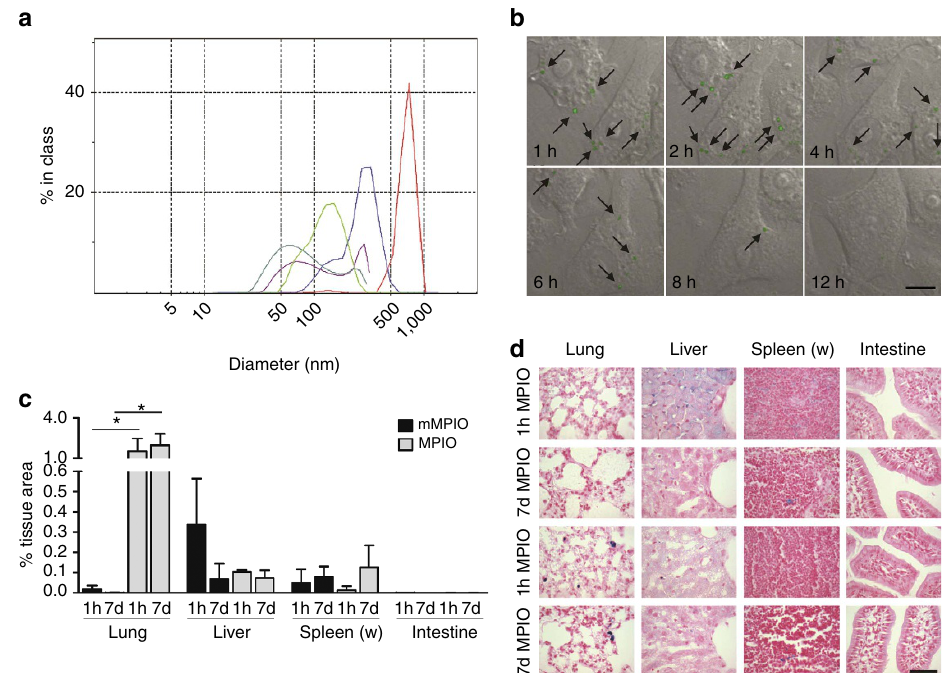
Figure 4 | In vitro and in vivo degradation studies. ( a ) DLS analysis of particle size distribution of mMPIO after addition of cathepsin L. Particle size was analysed at different time points 0h (red line), 1h (blue line), 4h (light green), 8h (purple) and 24h (dark green). Experiments were performed